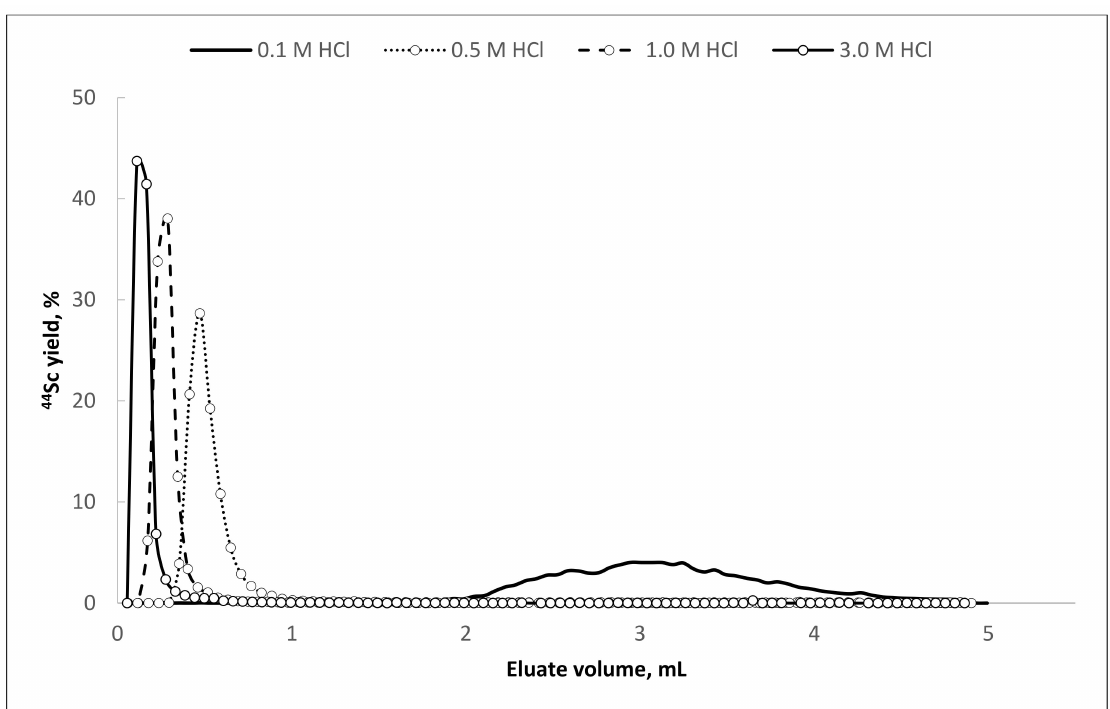
Figure 8. The elution curves of 44 Sc from Presep ® PolyChelate resin with HCl of various concentrations as eluent (flow rate—1 mL/min).